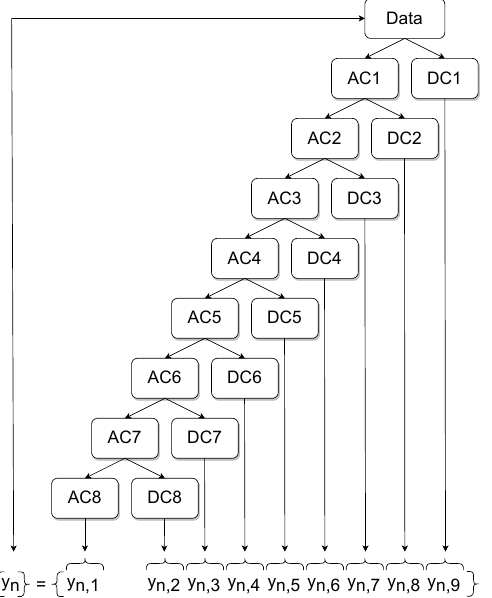
Figure 10. Feature Extraction from AC and DC of DWT